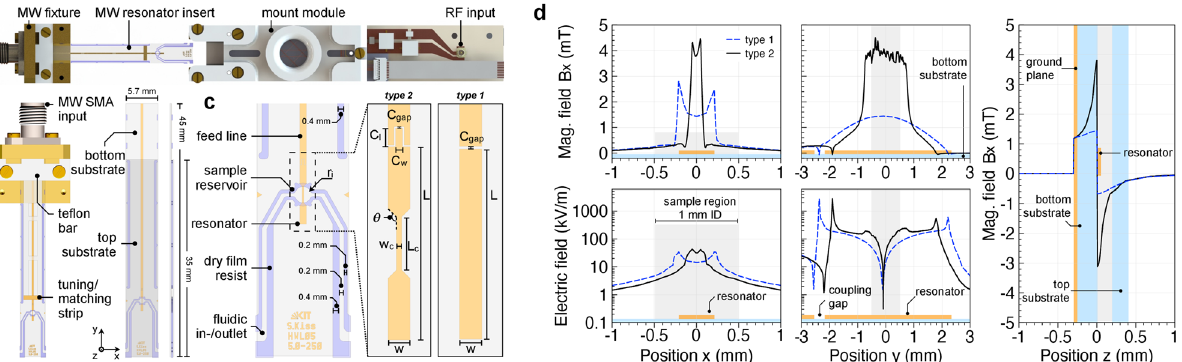
Figure 4. ( a ) Topview of the ODNP probe head model, shown with the MW resonator detached. ( b ) Overview of the MW fixture and the microfluidic chip. ( c ) Geometric details of the two designs of microstrip resonators (ground-plane not shown). ( d ) Electric and magnetic field profiles as extracted from the EM simulations for resonator type 1 and 2. Profiles are shown along the corresponding axes. As a guide to the eye, the lateral extent of the metallisation of the resonator (depicted in orange) and sample (grey) are indicated in the diagrams. Figure used with permission 41